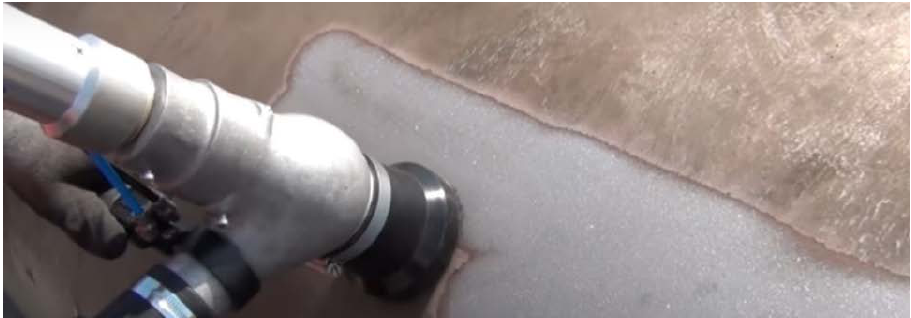
Figure 4. The process of shot blasting the surface of the hydraulic cylinder rod. During abrasive blasting, the abrasive is constantly regenerated, dust is discharged into the filter bag, and large debris is retained by the sieve. Replaceable catching nozzles allow you to perform work not only on flat surfaces, but also on curly ones. The swivel head allows you to clean parts in different spatial arrangements. The shot blast was carried out according to the passport data of the EDUCT-O-MATIC installation on a long rod with dimensions d = 250 mm, L = 1350 mm. The rod material is